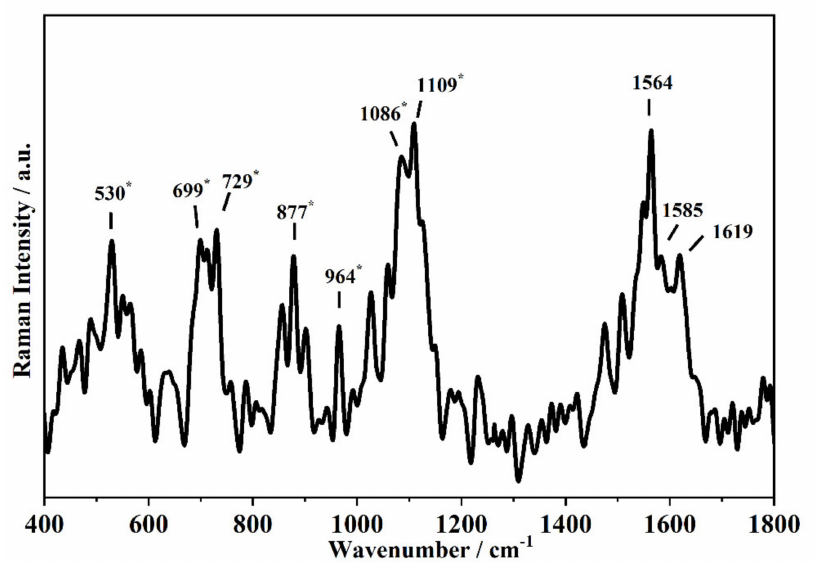
Figure 12. Raman spectrum of Bpy-SH@AuNR in water solution, collected in the 400–1800 cm − 1 range (laser source at 532 nm). The peak indicated with the symbol “*” as an apex is assigned to PEG-SH while the others to